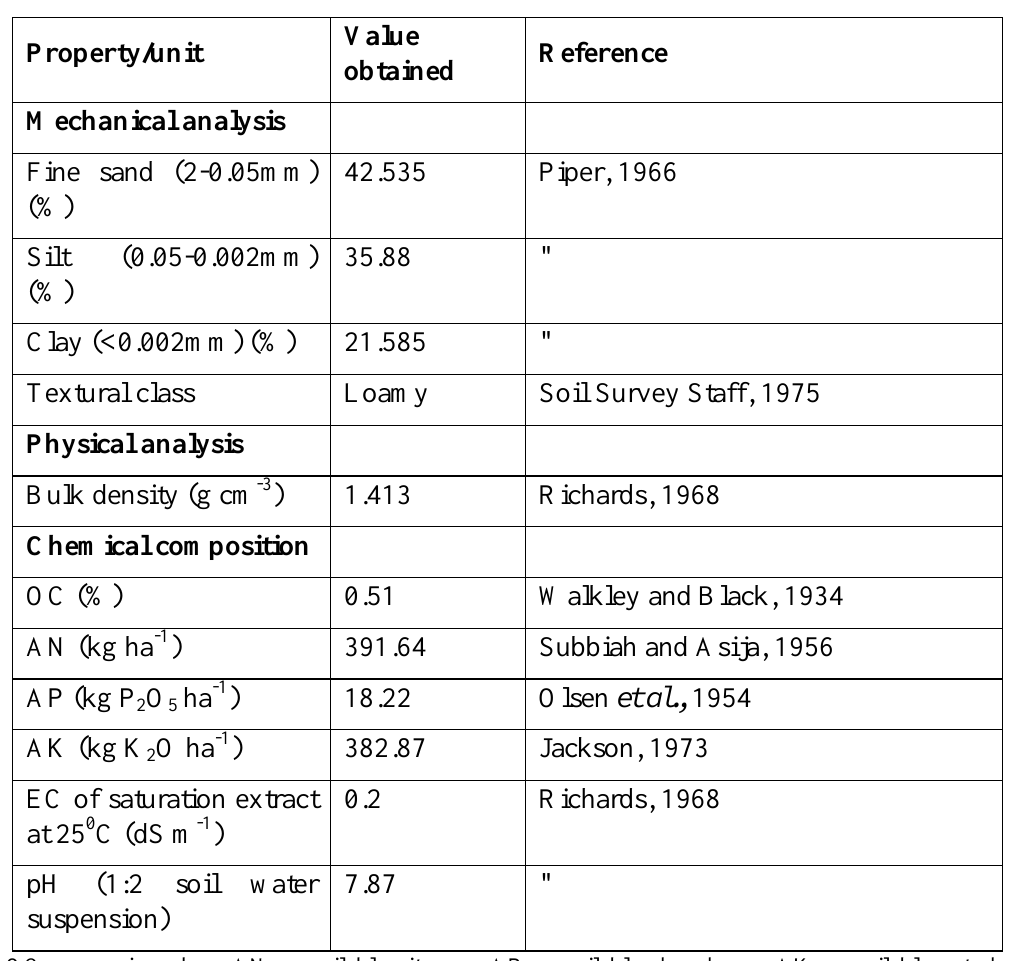
Table 1. Physical and chemical properties of soil of the experimental